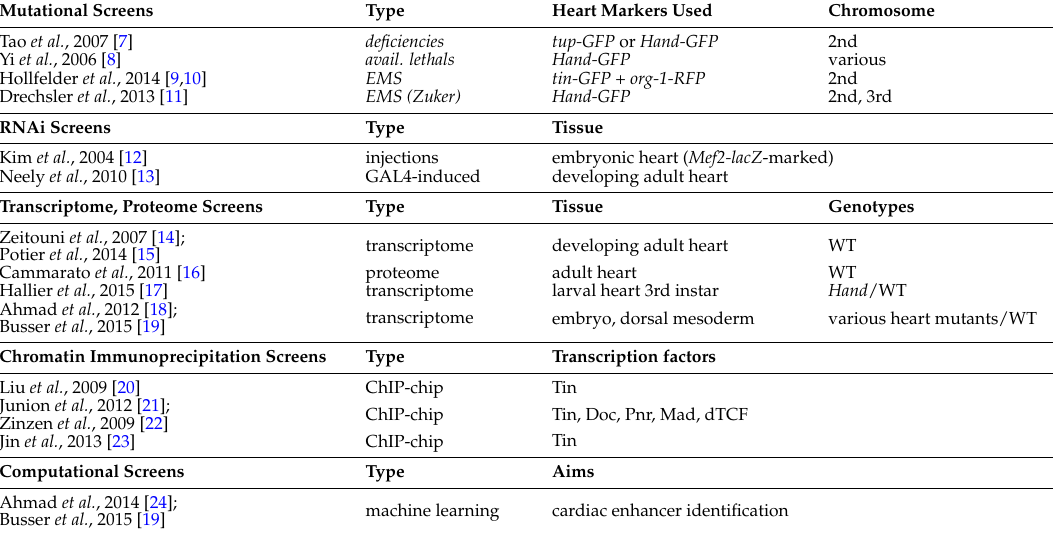
Table 1. List of the genome-wide studies related to Drosophila heart development discussed in the text. Mutational